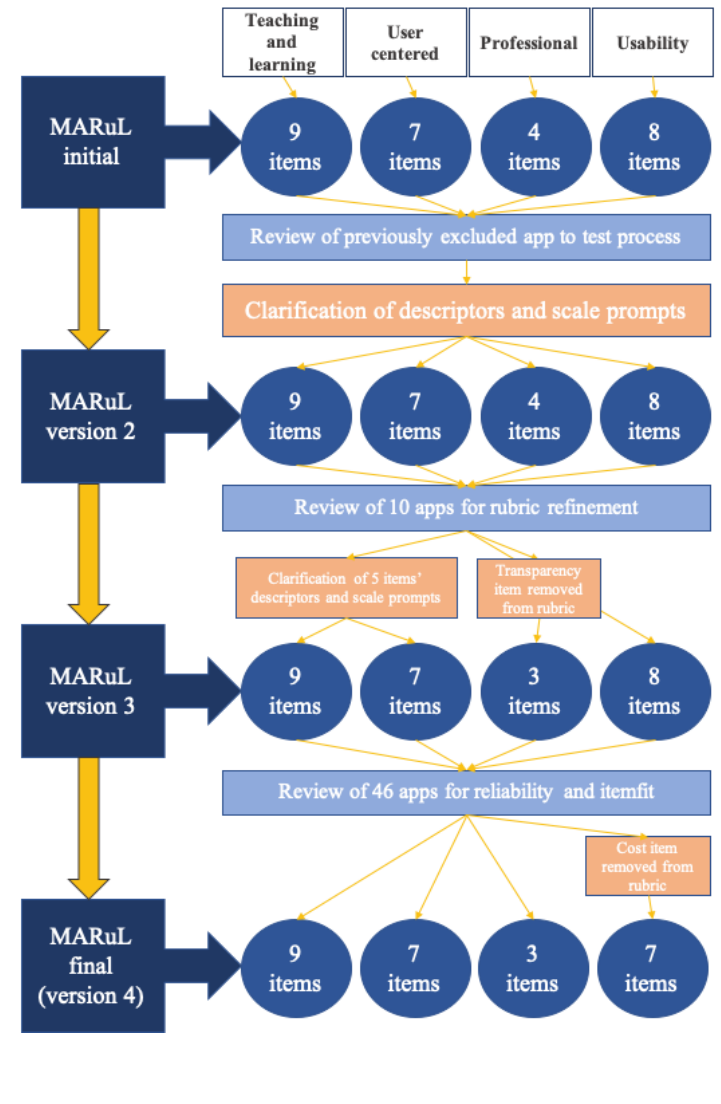
Figure 2. Rubric development process. MARuL: Mobile App Rubric for